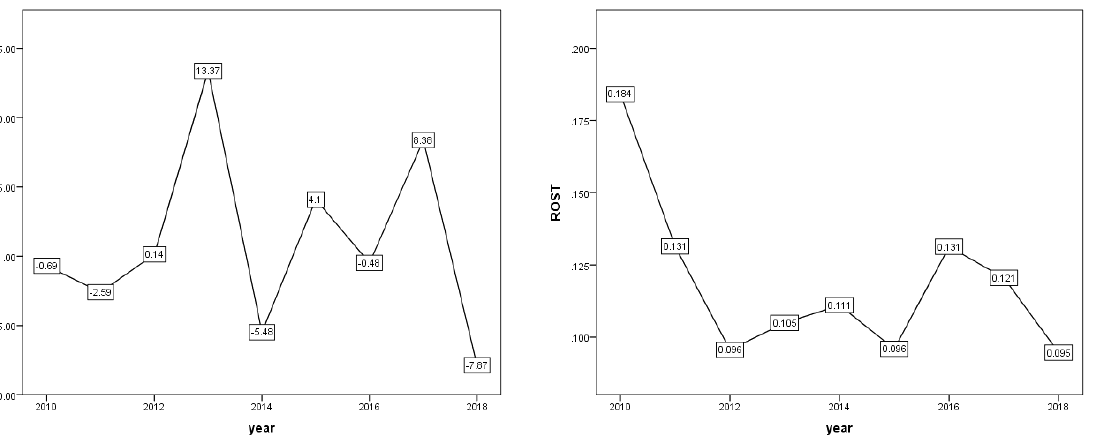
Figure 1. Market return Figure 2. Rate of stock